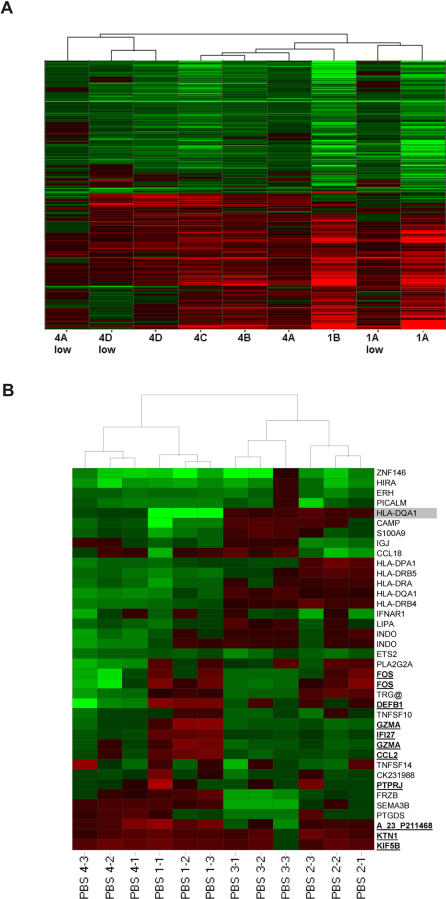
Unsupervised Global Gene Expression Profile of SARS-CoV–Infected Macaques and Individual Variation in Mock-Infected AnimalsRed corresponds to higher gene expression than that of the controls; green corresponds to lower gene expression.(A) Gene expression profiles result from comparing gene expression in lungs of experimental animals versus gene expression in lungs of mock-infected animals (pooled). Genes were included if they met the criteria of a 2-fold change or more (p ≤ 0.0001). A two-of-nine strategy allowed samples to cluster together if profile similarities existed based on timing of inoculation (n = 2 samples for day 1).(B) The number after PBS refers to the animal (i.e., PBS 1), while the number after the dash refers to the lung piece (i.e., PBS 1-1). Thirty-eight genes are displayed with an absolute fold change > 2 and p <0.0001 in at least two animal samples. Up-regulated genes are indicated in bold underline. Only one gene, HLA-DQA1, was down-regulated > 5. No up-regulated genes met these criteria in mock-infected animals. Separate mock samples (i.e., PBS 1-1) were compared to the total mock pool.